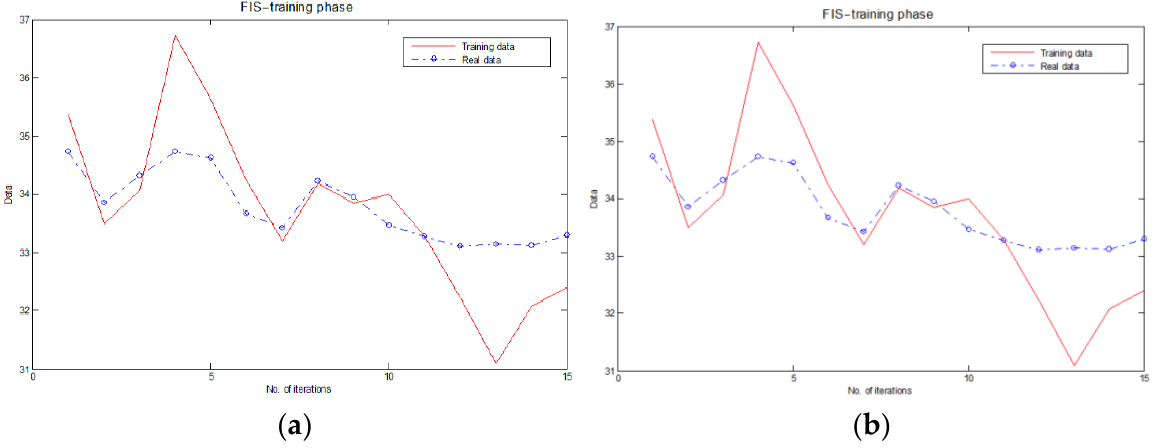
Figure 9. FIS – FCM error evolution with iterations in the ( a ) training and ( b ) testing phases. Figure 9. FIS–FCM error evolution with iterations in the ( a ) training and ( b ) testing